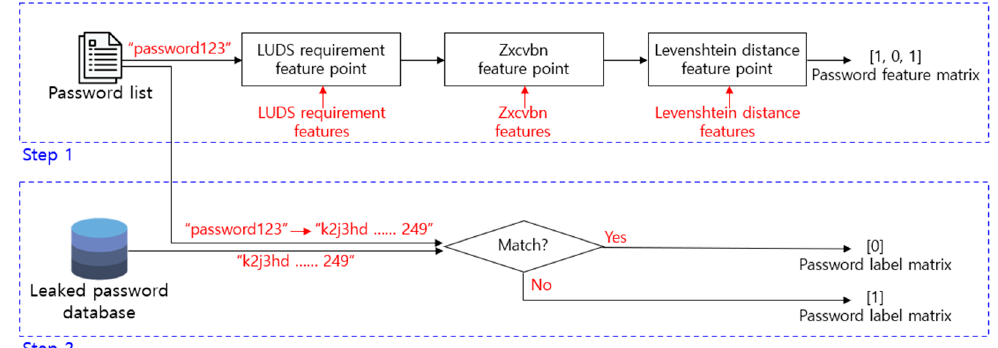
Figure 7. Process of extracting password features.